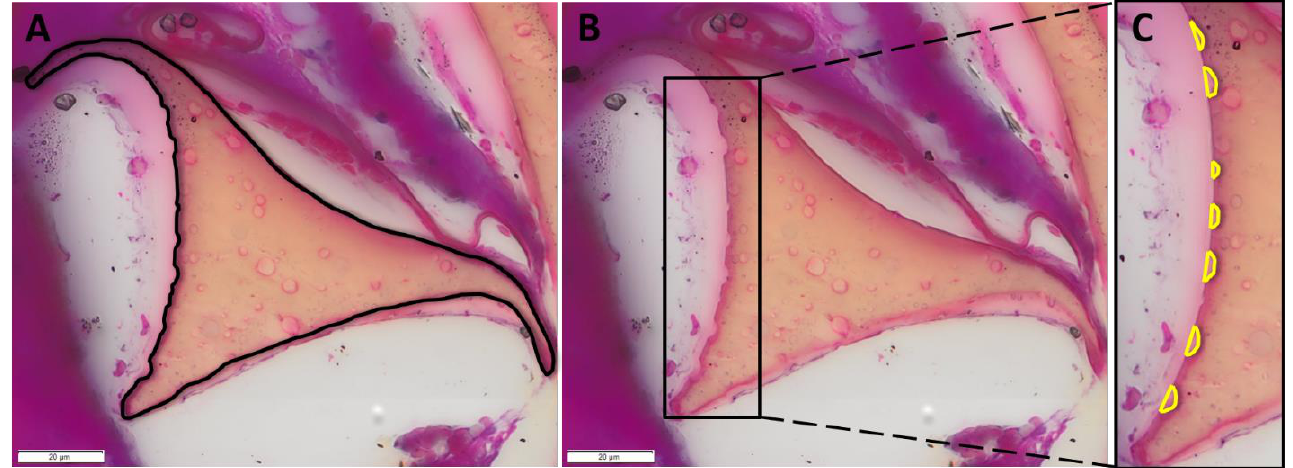
Figure 5. The foam struts measured for degradation were first measured for visible strut area ( A ) and then evaluated for measurable degradation area ( B ). Each degradation region was measured along the strut edge ( C ), assuming the presence of the strut edge smoothness observed from 0-day images (see Figure 3). Tissues were stained with hematoxylin and eosin (H&E) (20 μm) .